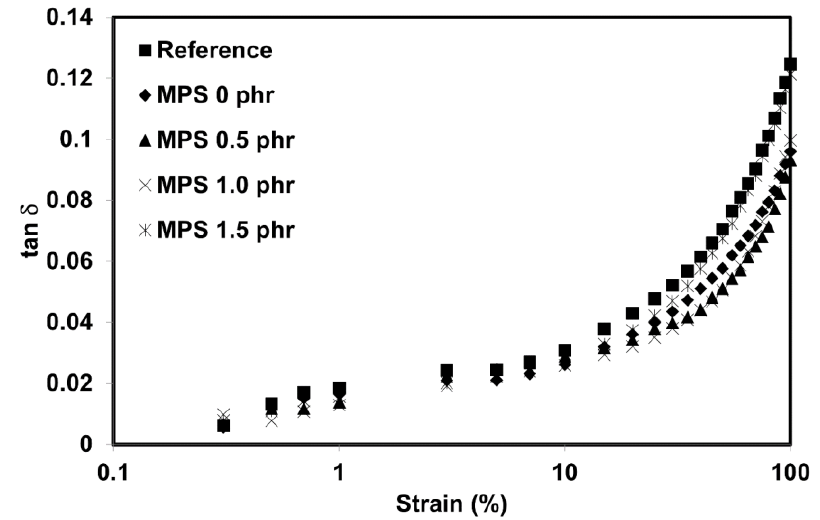
Figure 10. Damping characteristic (tan δ ) of NR / HNT composites in the presence of MNR / MPS as a dual compatibilizer.